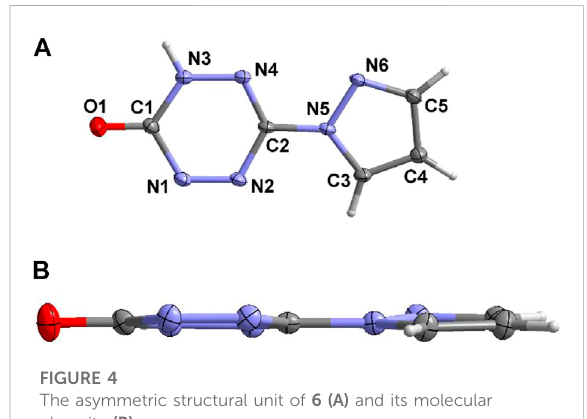
The asymmetric structural unit of 6 (A) and its molecular planarity (B)